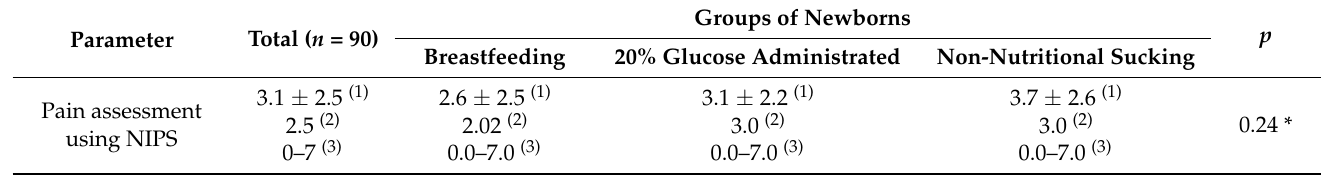
Table 2. Statistical correlation between pain assessment and intervention